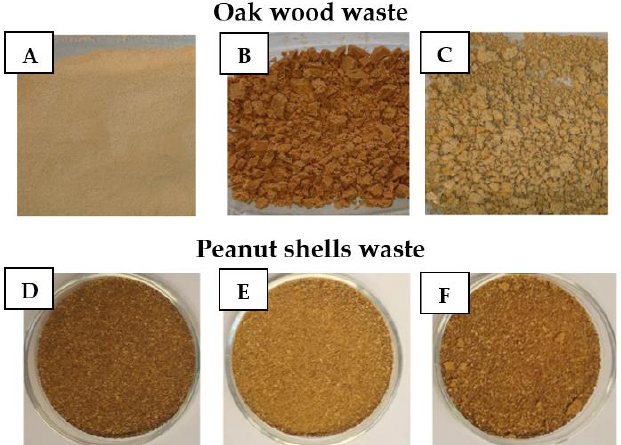
Figure 2. Lignocellulosic filler for the application in epoxy composites: ( A ) unmodified waste oak flour; ( B ) mercerized oak flour; ( C ) silanized oak flour; ( D ) unmodified peanut shells flour; ( E ) mercerized peanut shells; and ( F ) silanized peanut shells flour.